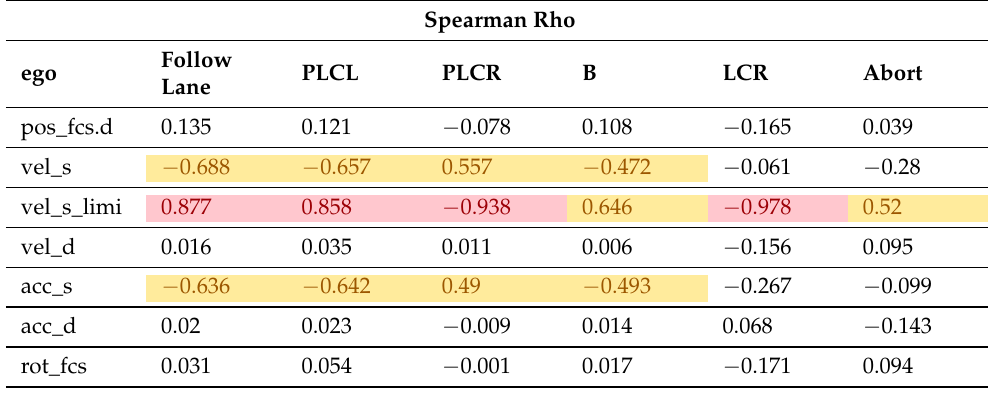
Table 5. Table with values of Spearman Rho correlation for attributation of vel_s_limitation with respect to values of features which describe ego state. Red color means strong correlation, and yellow—medium strength of correlation.